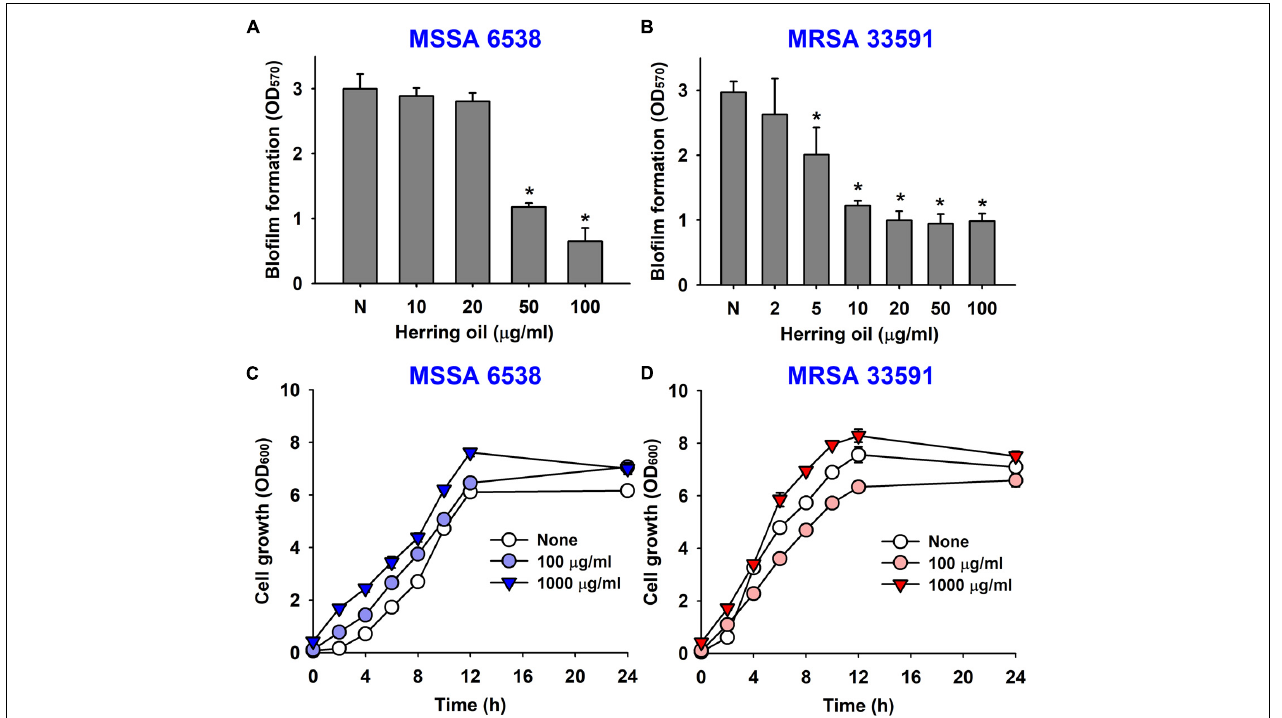
FIGURE 1 | Effects of herring oil on biofilm formation by Staphylococcus aureus strains and on their antimicrobial activities. S. aureus (MSSA 6538 or MRSA 33591) biofilm formations (OD 570 ) were quantified in the presence of herring oil for 24 h in 96-well polystyrene plates (A,B) . Planktonic cell growths (OD 600 ) of S. aureus cells (MSSA 6538 and MRSA 33591) were measured in the presence of herring oil in 250 ml flasks agitated at 250 rpm (C,D) . ∗ p < 0.05 vs. non-treated controls.